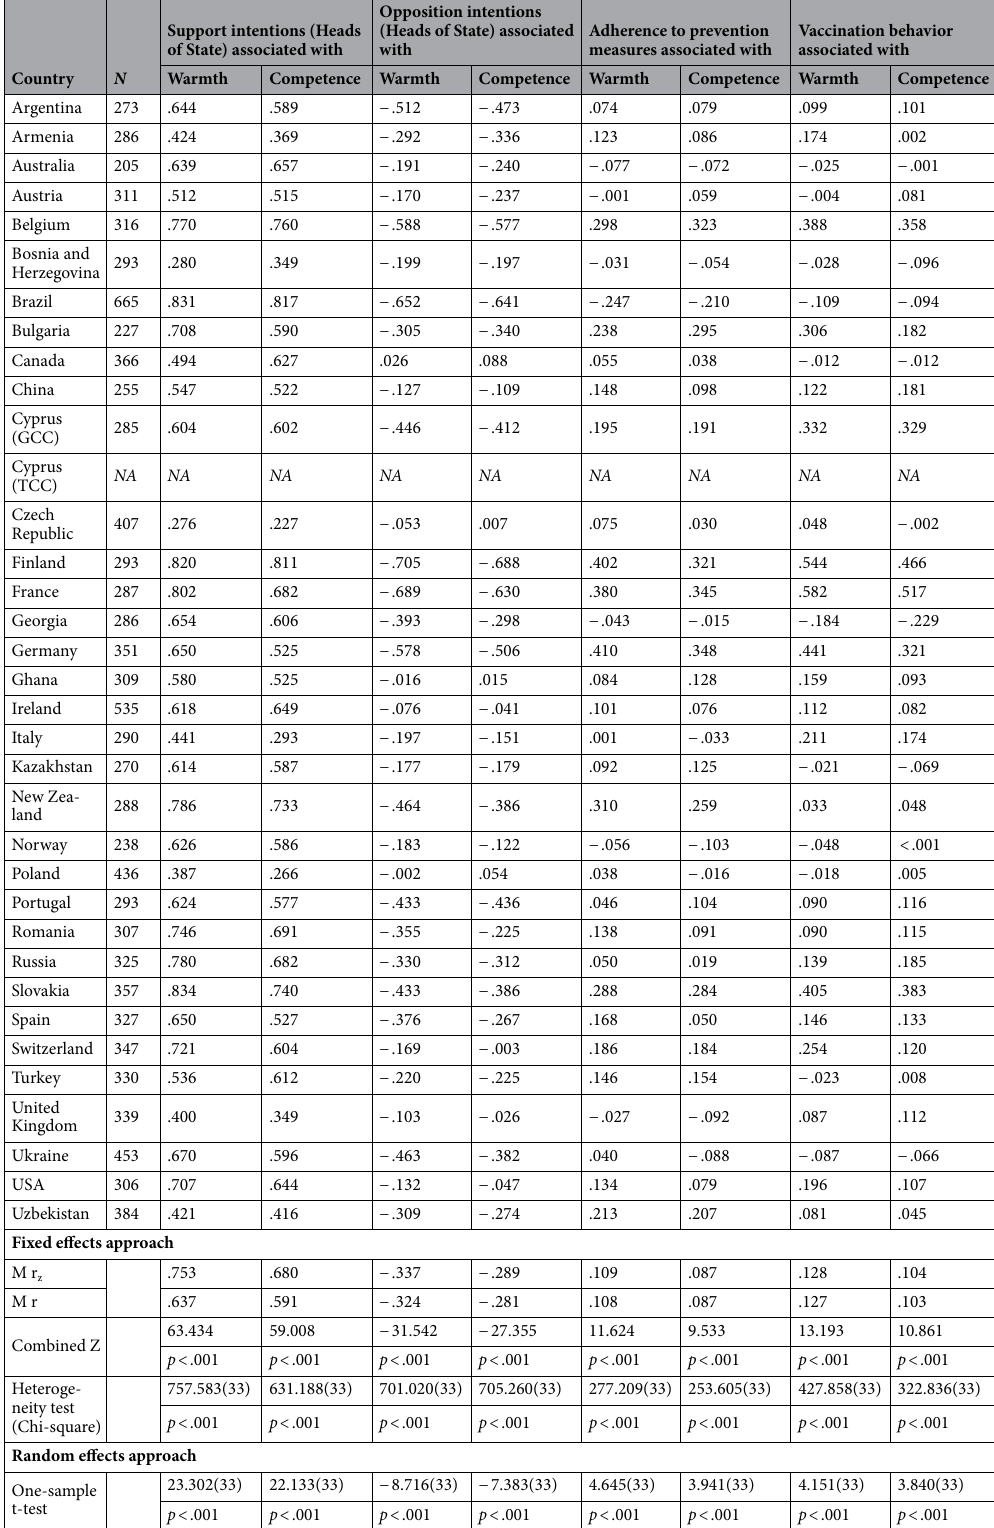
Table 1. Relationships between warmth and competence perceptions of the protagonist ‘heads of state’ with pandemic-related behavioral intentions and behaviors within and across 35 countries. TCC